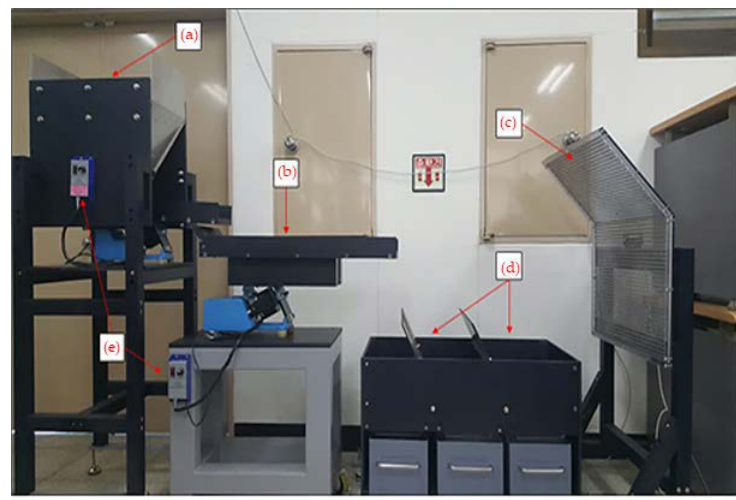
Figure 3. Photograph of the induction electrostatic separation unit: ( a ) Feeder, ( b ) positive electrode, ( c ) negative electrode, ( d ) splitter and bins, and ( e ) feed rate controller. Table 2. Parameters used in the induction electrostatic separator.